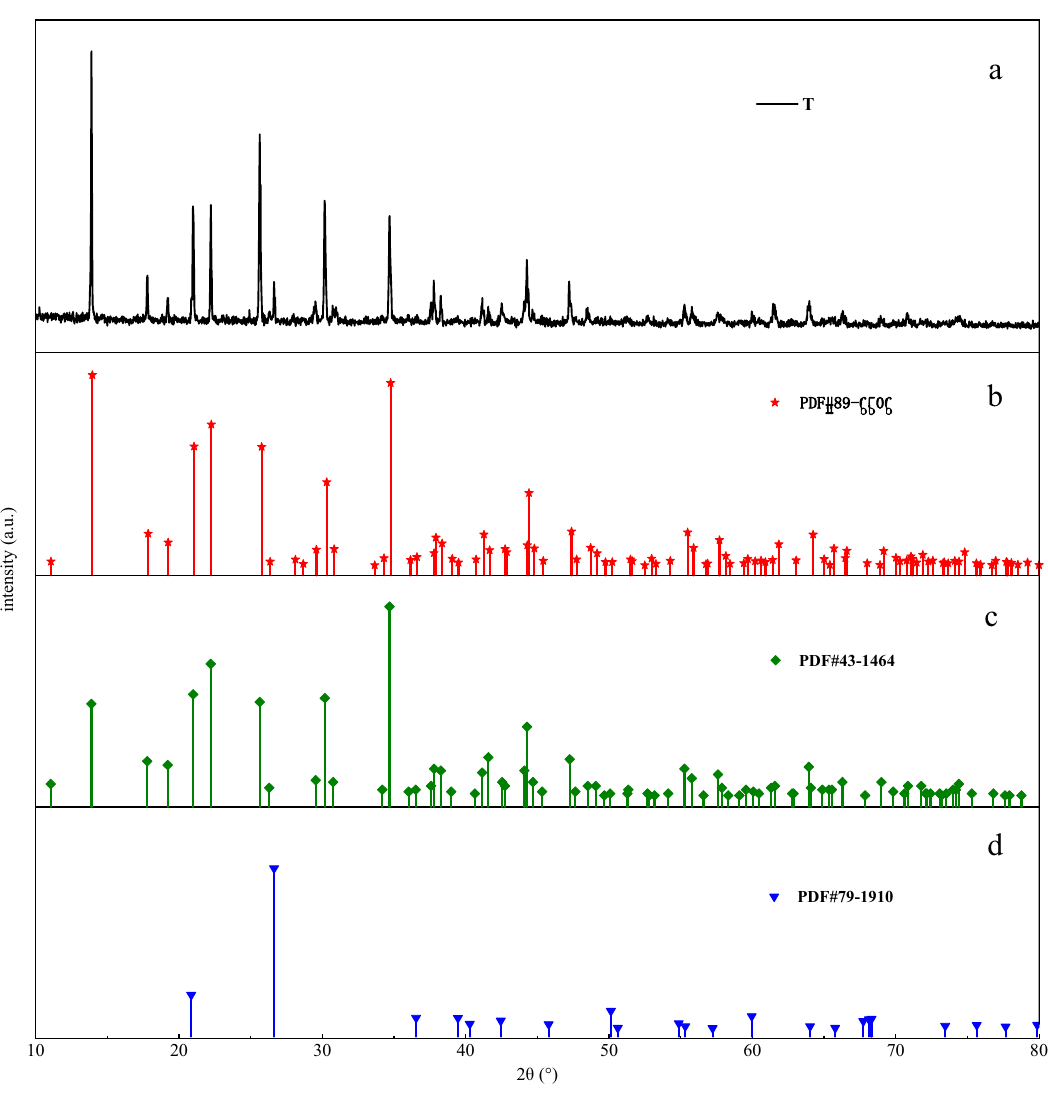
Figure 9: XRD patterns of tourmaline and its corresponding power di ff raction fi le ( PDF )